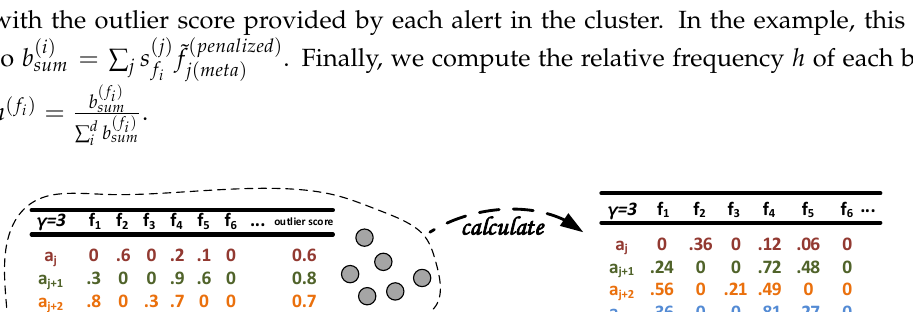
histograms H attr ( C i ) and H attr ( C j ) obtained from clusters C i and C j . Although the two- sampled Kolmogorov–Smirnov test can be modified to function on discrete data, as it applies for binned values in the histogram, it is normally used for continuous data [63]. the Bhattacharyya distance measure [64]. Here, we apply the Bhattacharyya distance } } = { h ( b ) D B ( H i , H j ) between the histograms H i = { h ( b ) b = 1,..., B and H j b = 1,..., B for B equi- i j width bins b with the (relative) frequency h , which is defined as given in Equation (5). It takes values in the range of ( 0 ≤ D B ≤ ∞ ) . BC is the Bhattacharyya Coefficient (Equation (5)) for which 0 ≤ BC ≤ 1 applies. We obtain identical histograms and thus identical signatures sig attr between two attack scenarios if D B == 0 applies. The higher the D B , the more different the signatures